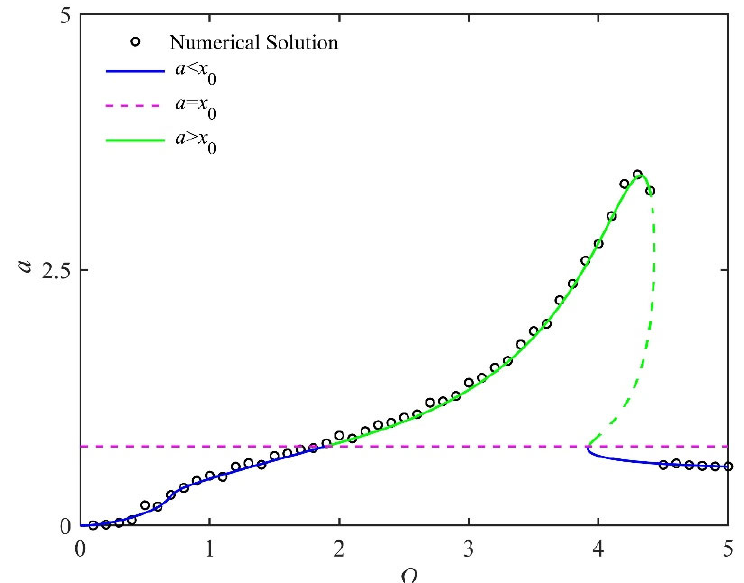
Figure 5. The results of the amplitude-frequency response function and the numerical solution with ζ = 0.1443, K 0 = 20, K 1 = 1, K 3 = 0.0256, H = 1, p = 0.5, α = 0.9, A =